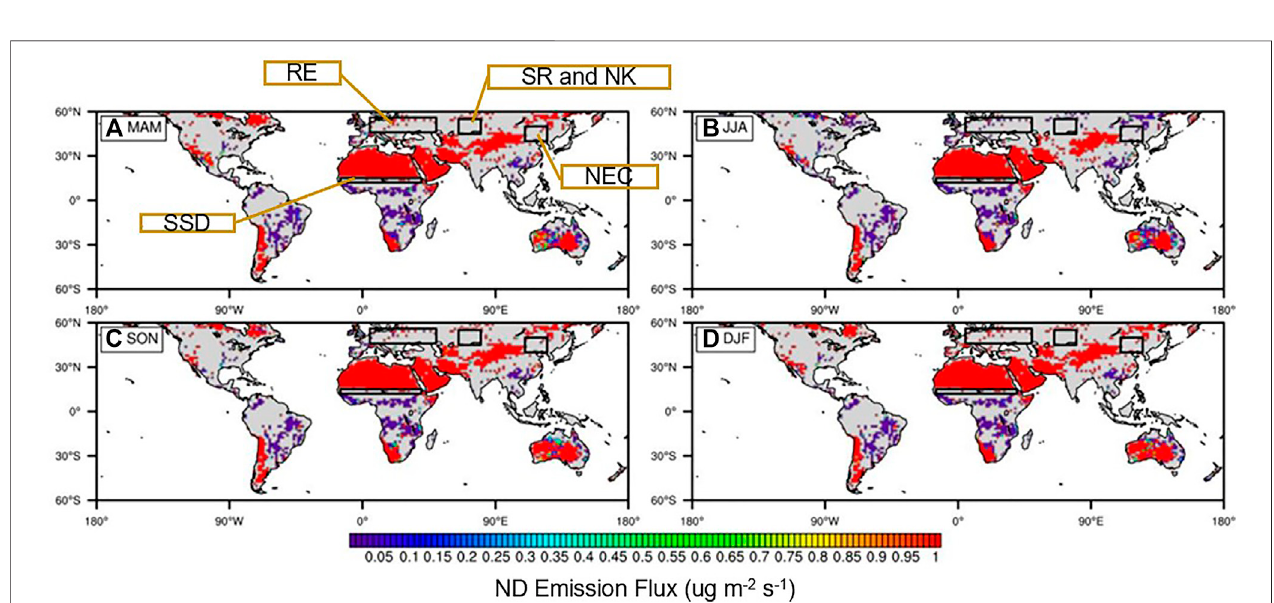
FIGURE 5 | Seasonal variations of the ND emission fl ux at the global scale during 2001 – 2018. The black boxes correspond to the four major areas in Figure 7SR and NK: southern Russia and northern Kazakhstan (45 ° N~55 ° N, 65 ° E~80 ° E); NEC: Northeast China (40 ° N~50 ° N, 110 ° E~125 ° E); SSD: southern side of the Sahara Desert (12 ° N~15 ° N, 15 ° W~0 ° – 40 ° E); RE: Russia in Europe (46 ° N~56 ° N, 5 ° E~50 °